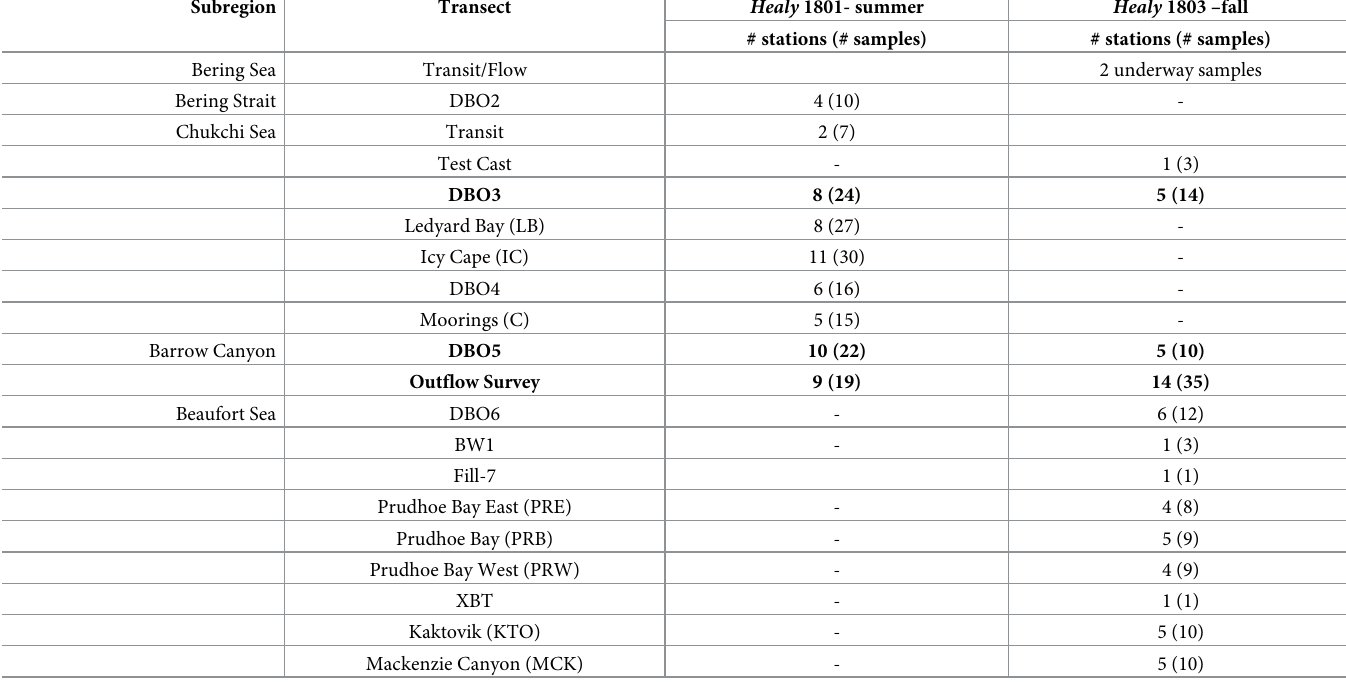
Table 1. Summary of sampling locations. The number of stations sampled during summer Healy 1801 and fall Healy 1803 cruises are grouped by subregion. Common transects between both cruises are in bold. See S1 Table and text for detail.